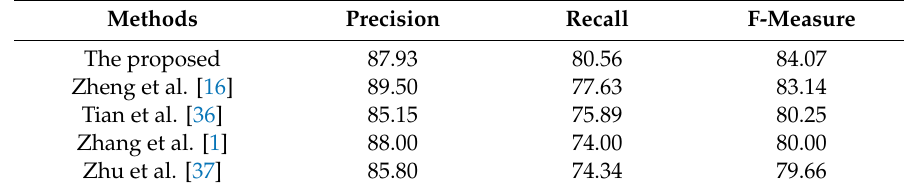
Table 3. Comparison of di ff erent text detection methods’ performance on the ICDAR2013 dataset